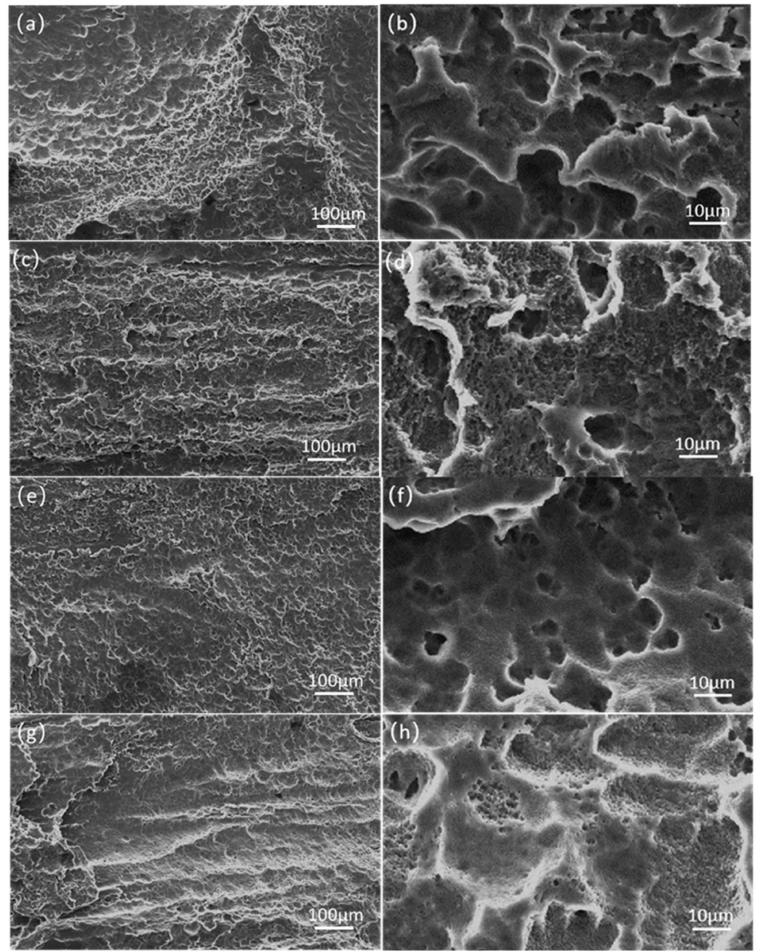
Figure 11. SEM micrographs of anodes after discharge for 3.5 h at a current density of 100 mA/cm 2 ( a , b ) Al-Mg-Sn-Ga, ( c , d ) Al-Mg-Sn-Ga-0.08Bi, ( e , f ) Al-Mg-Sn-Ga-0.10Bi, ( g , h )